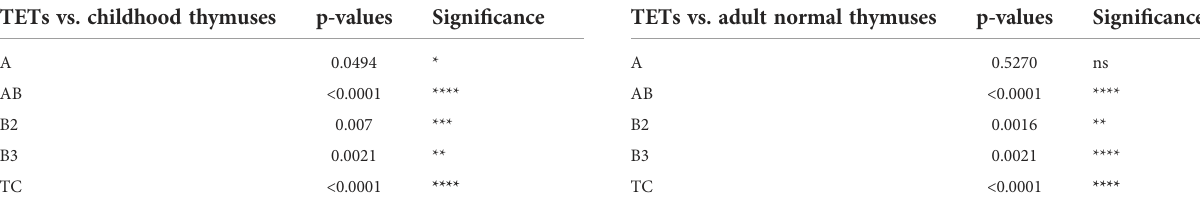
TABLE 2 Statistical values of the comparison of WNT4 gene expression in thymic epithelial tumors (TETs), including thymomas and thymic carcinomas, with normal childhood thymuses (A, n = 6) and normal adults thymuses (B, n = 15) as represented in Figure 1 (two-tailed Student ’ s t - test was applied for statistical analysis).